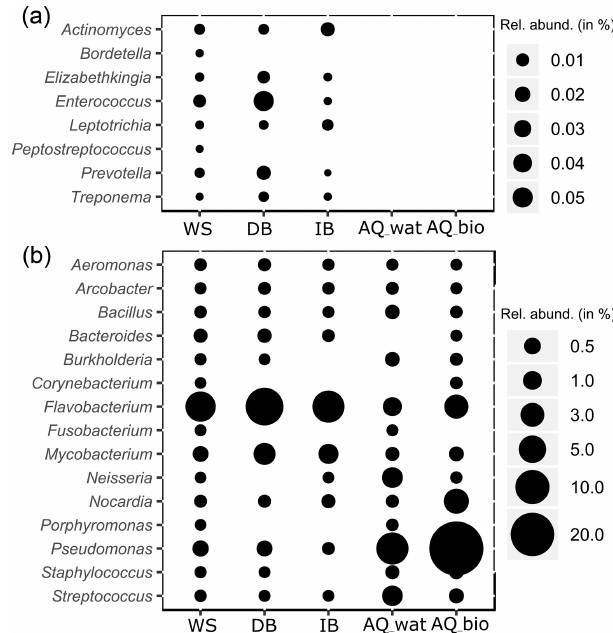
Figure 4. Relative numbers of potentially pathogenic bacterial gen- era along the watershed. The relative abundance (rel. abund.) of bacterial genera exclusively detected in upper compartments (a) or both in the upper compartments and aquifer (b) are presented. Size of bubbles is proportional to the relative abundance (in %) of each bacterial genus per sampled compartment. WS: runoff waters from the watershed; DB: sediments from the detention basin; IB: sedi- ments from the infiltration basin; AQ_wat: aquifer waters; AQ_bio: aquifer clay beads